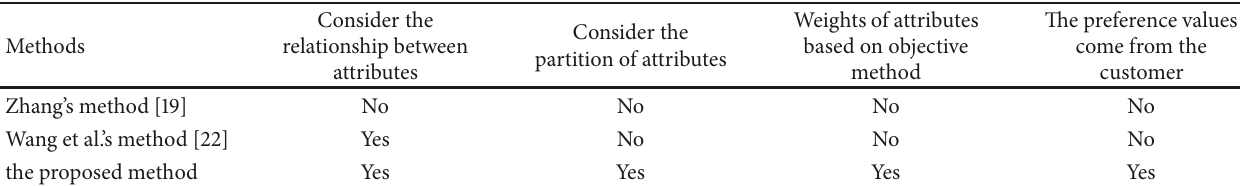
Table 11: The comparison orders of the characteristics for different